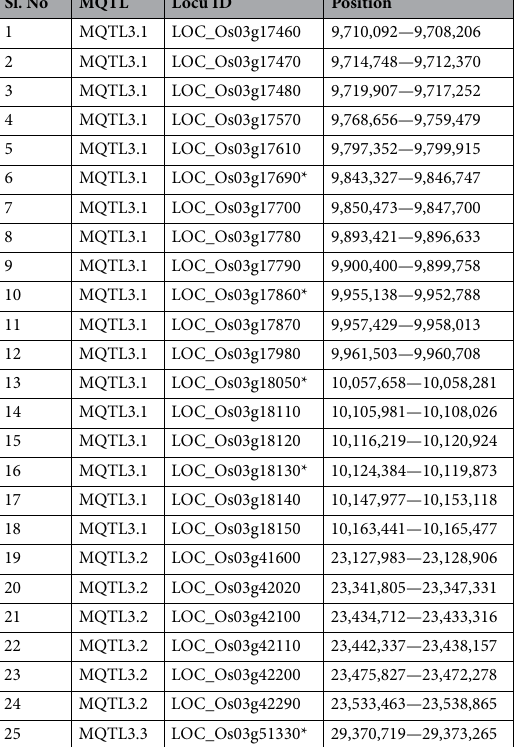
Table 3. List of characterized genes underlying identified significant MQTL. *genes directly involved in grain weight or grain shape related biological processes.